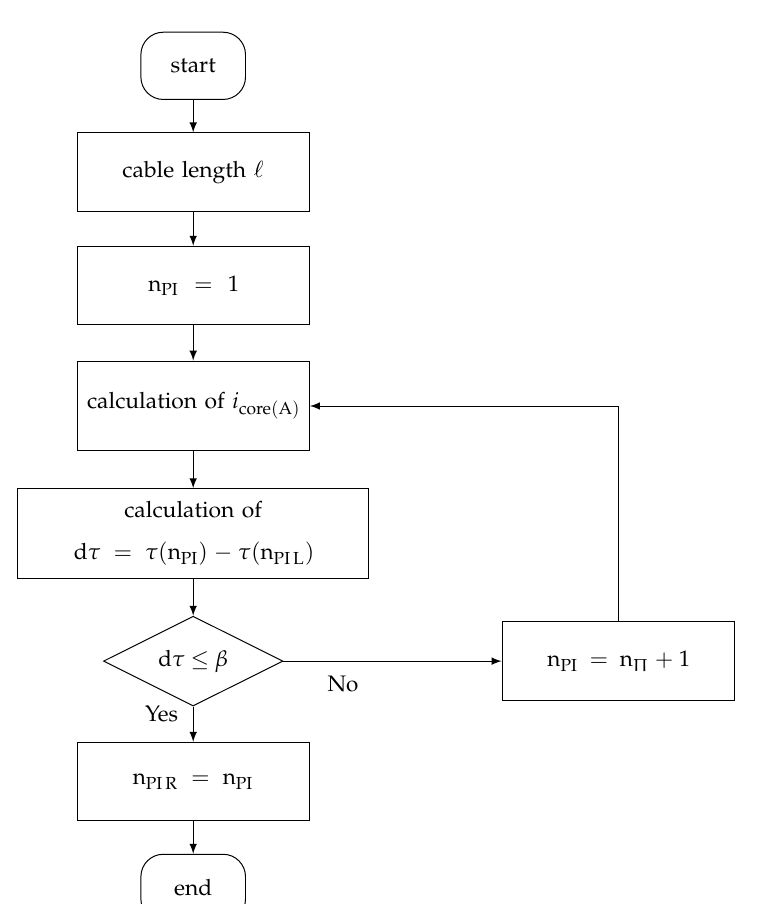
Figure 13. Optimization the number of PI-sections—second algorithm.